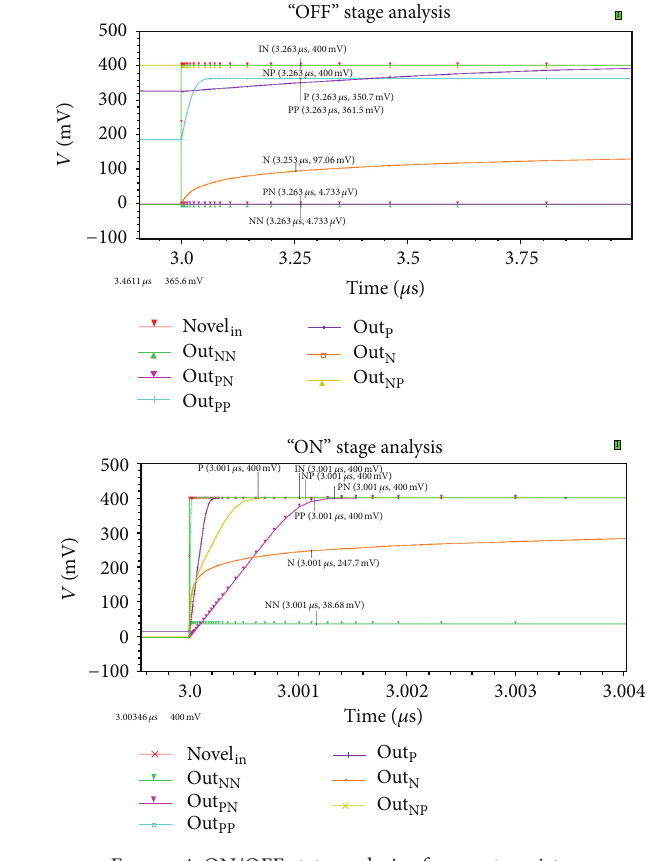
Figure 4: ON/OFF state analysis of access transistors.